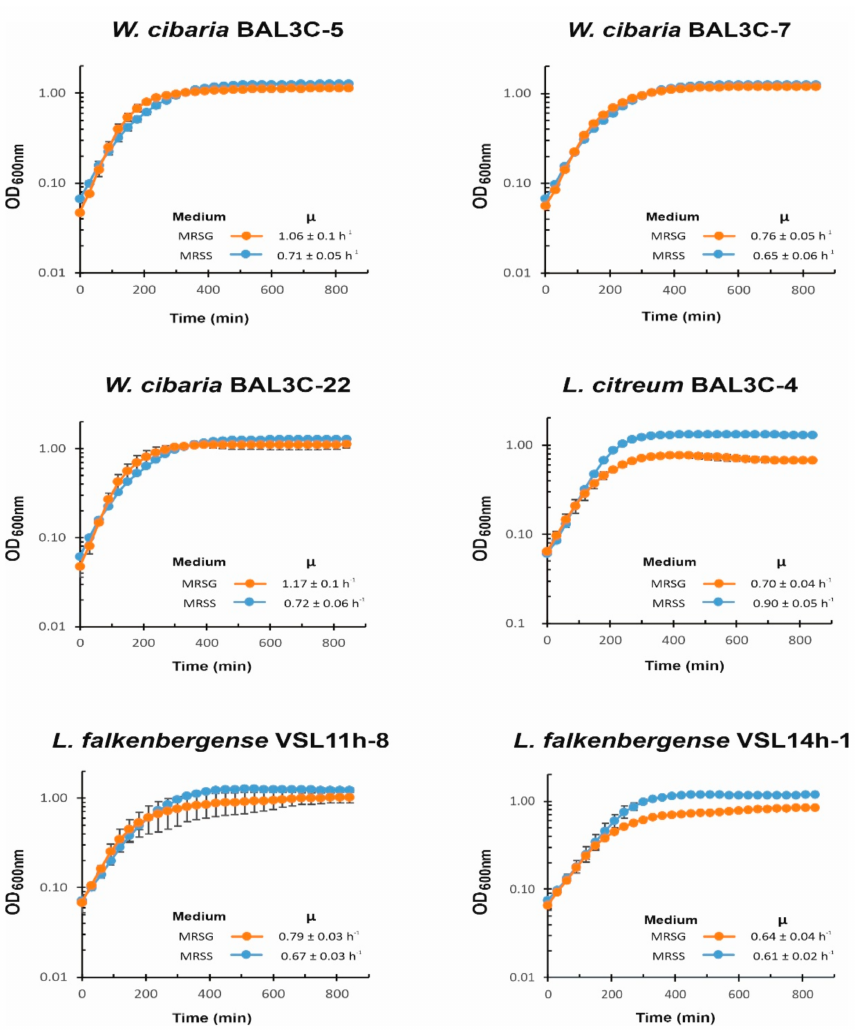
Figure 5. Influence of the presence of sucrose on lactic acid bacteria growth. A comparative analysis in real time of culture growth in MRS medium supplemented with either 2% sucrose (MRSS) or 2% glucose (MRSG), as well as the inferred growth rate during exponential phase, are